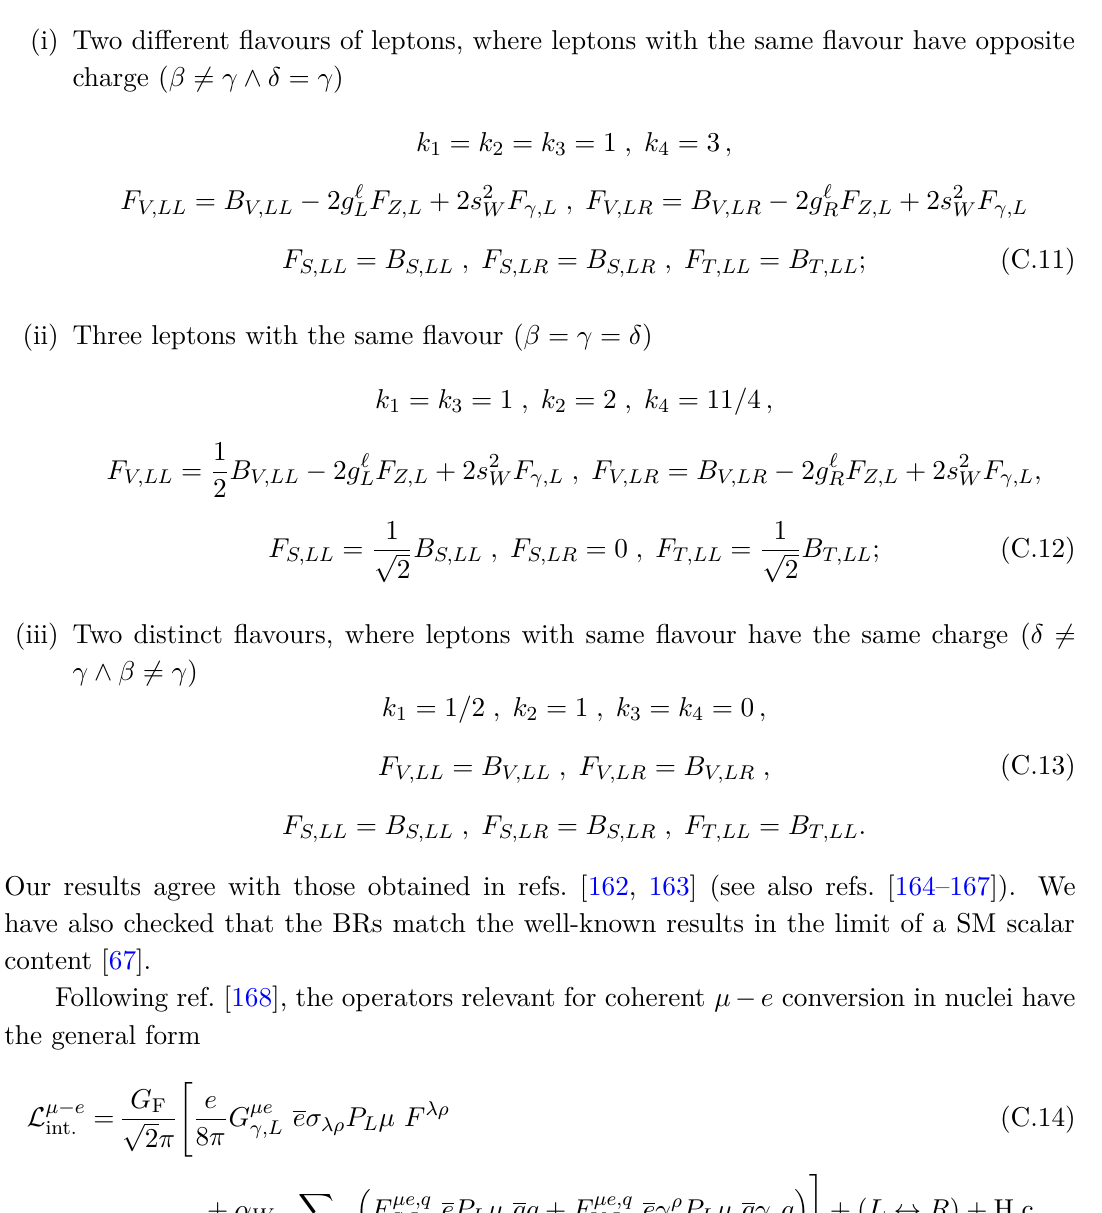
Figure 12 . Generic u -type (on the left) and d -type (on the right) semi-leptonic box diagrams contributing to the µ − e conversion process. Although for illustrative purposes we only display the W ± -boson diagrams, the G ± and H ± contributions were also included in our